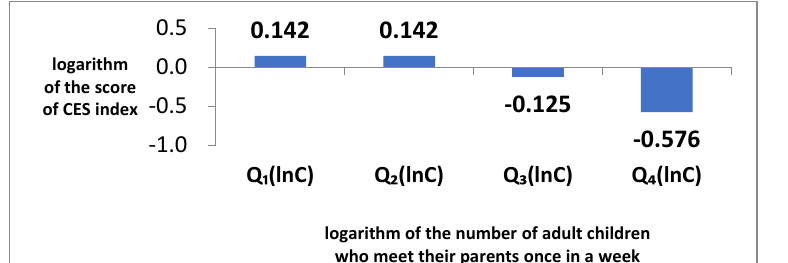
Figure 2. The effect of contact care by adult children at relieving depression in older adult individuals based on the lnC value. Note: Q i ( lnC ) indicates the first quartile of lnC. The x -axis is the logarithm of the number of adult children who visit their parents once a week. The y -axis is the logarithm of the Center for Epidemiological Studies (CES) index score. Source: authors’ calculation using the result of empirical analysis.